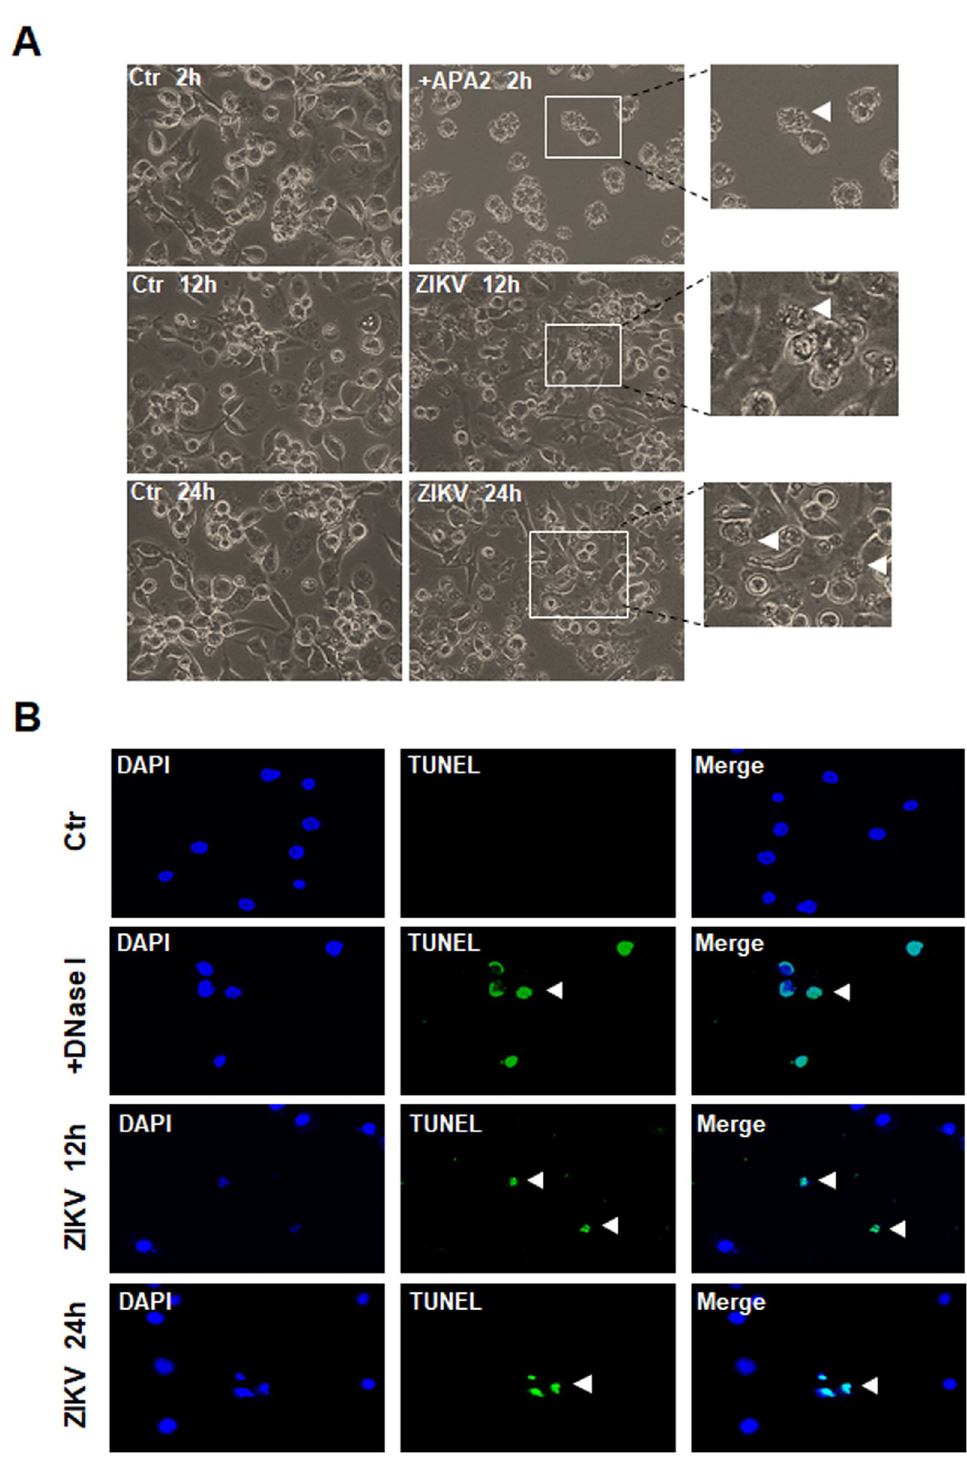
Fig 4. ZIKV infection induced apoptosis in macrophages. PMA-differentiated THP-1 cells were infected with ZIKV and observed under a light microscope at 12 and 24 hrs p.i. for the cells showing apoptotic blebing (arrow) ( A ). The cells were treated with 10 μ M of apoptosis activator 2, a caspase3 activator, for 2 hrs as a positive control. A TUNEL assay was applied to ZIKV-infected THP-1 cells at 12 and 24 hrs p.i. and the TUNEL positive cells were shown (arrow). The cells were treated with 20 U/mL of DNase I for 10 min as a positive control ( B ).